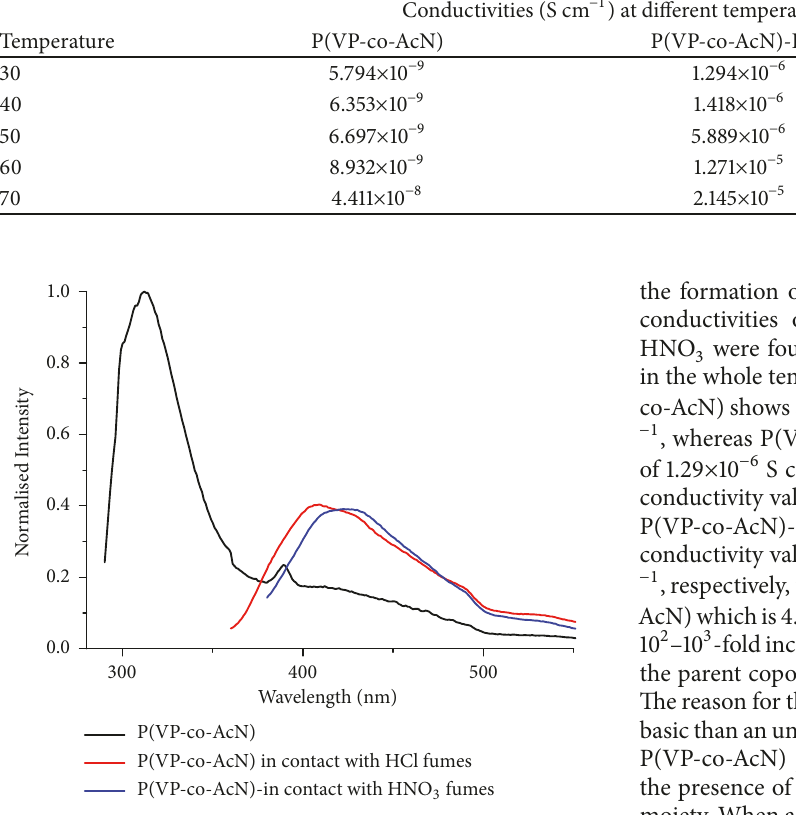
Figure 13: Fluorescence spectra of copolymer before and after contact with corresponding acid